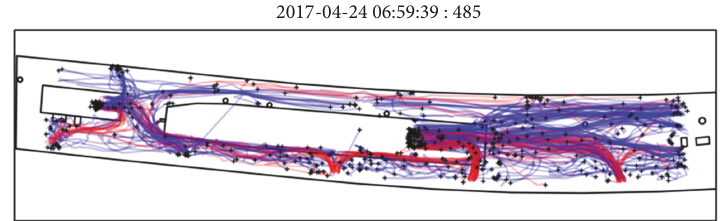
Figure 2: Plot of all passengers’ paths to identify the position of train doors (blue = boarding passengers; red = alighting passengers) in the case study of